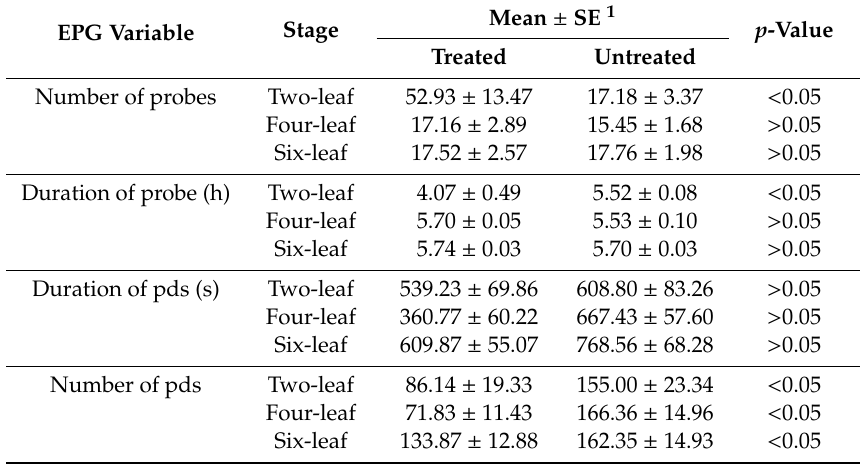
Table 1. Effect of imidacloprid seed treatments on aphid feeding behaviors in overview of probing. EPG